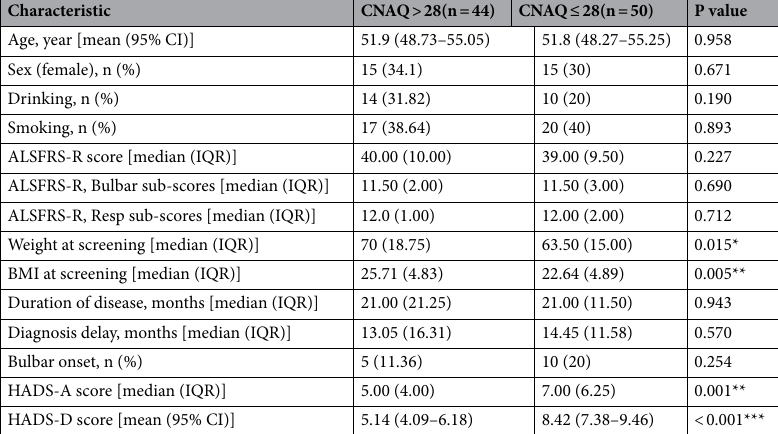
Table 3. Characteristics of ALS patients with intact appetite (CNAQ > 28) and loss of appetite (CNAQ ≤ 28) at the time of baseline. CI confidence interval, IQR interquartile range, BMI body mass index, ALS amyotrophic lateral sclerosis, ALSFRS-R ALS Functional Rating Scale-Revised, HADS-A Hospital Anxiety and Depression Scale-Axiety, HADS-D Hospital Anxiety and Depression Scale-Depression. *p < 0.05; **p < 0.01; ***p < 0.001.